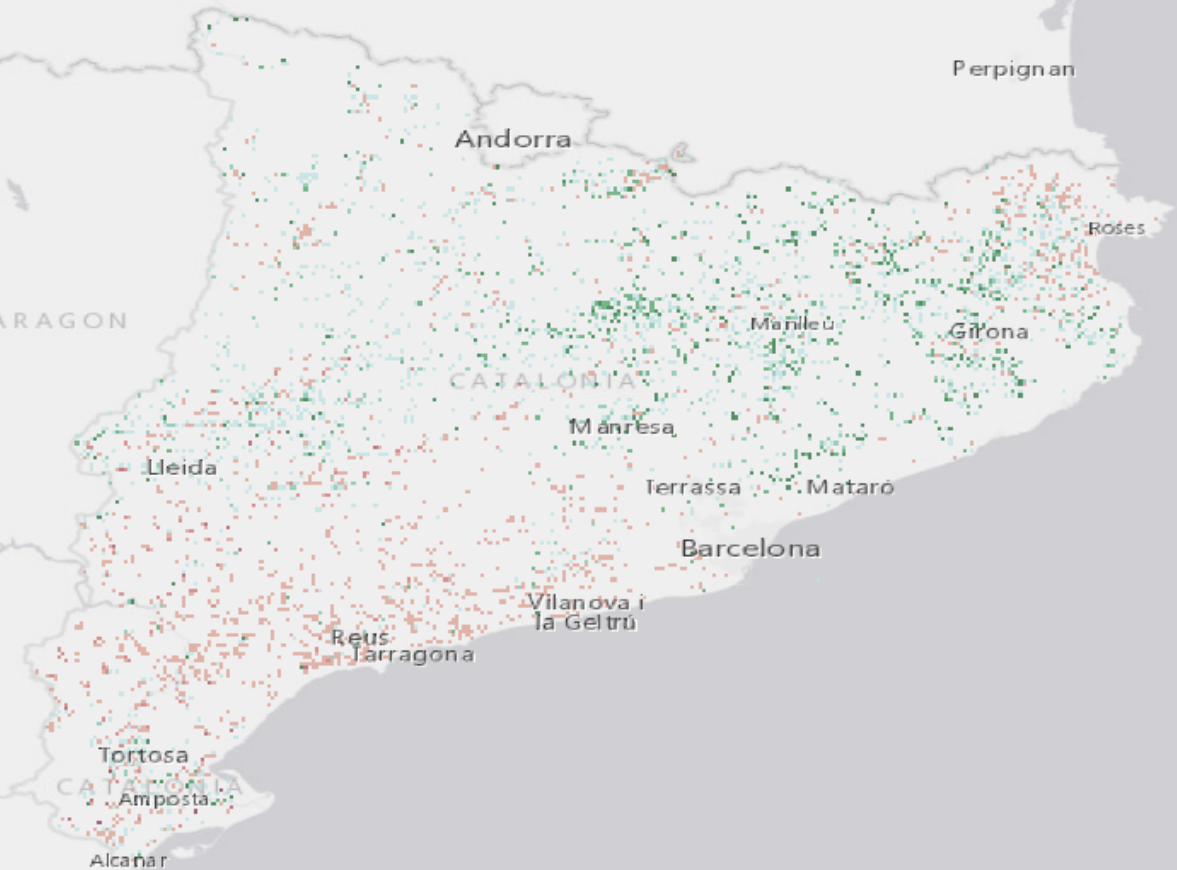
Figure 5. The map of Catalonia after the AIA has been applied, showing remaining needs in manure (orange color) and remaining availability of manure (green color). The color intensity indicates different needs or availability of manure. For example, darker colours of green and orange correspond to larger availability or needs of manure at some farm. Please note that this map depicts only manure availability and needs of farms after the application of AIA. This means that livestock farms whose manure availability is zero and/or crop farms whose needs in manure as fertilizer are zero, do not appear on the